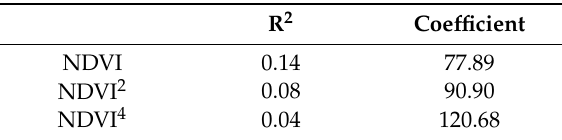
Table 2. Results of different order regressions between DN − 20 and the real NDVI for the 2006 RCNL image.